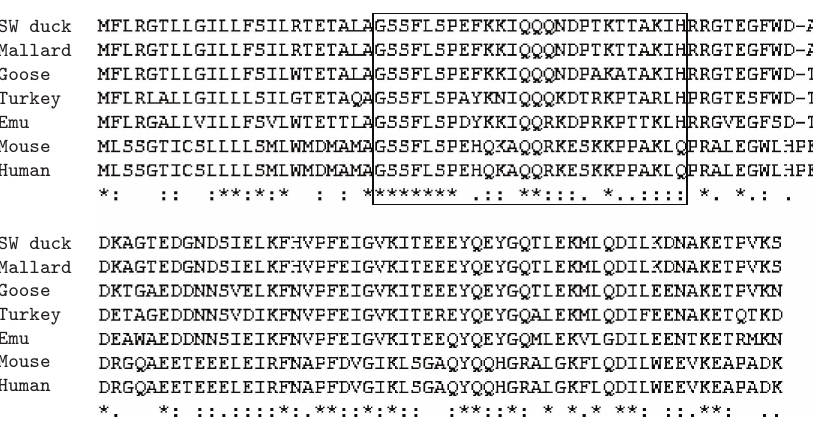
Figure 1: cDNA and deduced amino acid sequence of the dGHRL gene. The arrowheads indicate the locations of introns. Polyadenylation signal is boxed. The asterisk ( ∗ ) represents the putative stop codon (TGA). The nucleotide sequence is deposited in GenBank (EF613551).